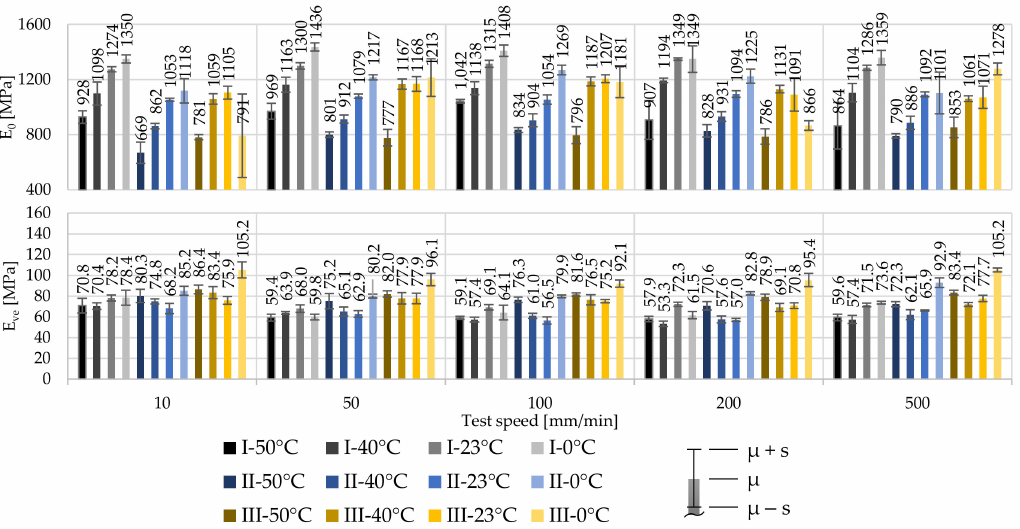
Figure 9. Influence of the test temperature and test speed on E 0 and E ve for 100 µ m ETFE foils of producers I, II, and